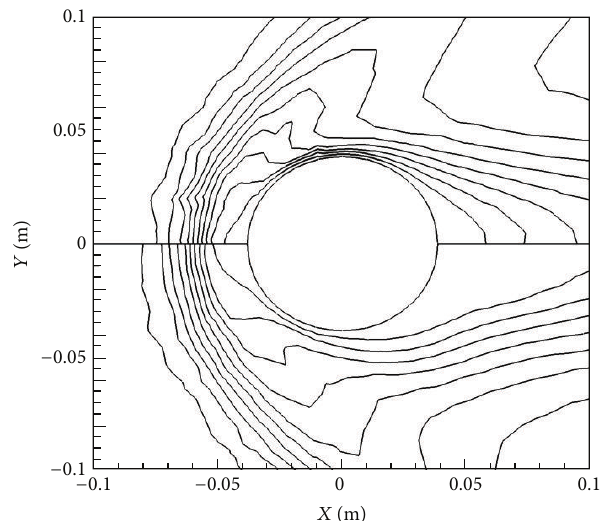
Figure 13: Comparison of 𝑈 velocity contours without magnetic field (top) and with 𝐵 max = 2 T oriented in 𝑌 -direction (bottom).